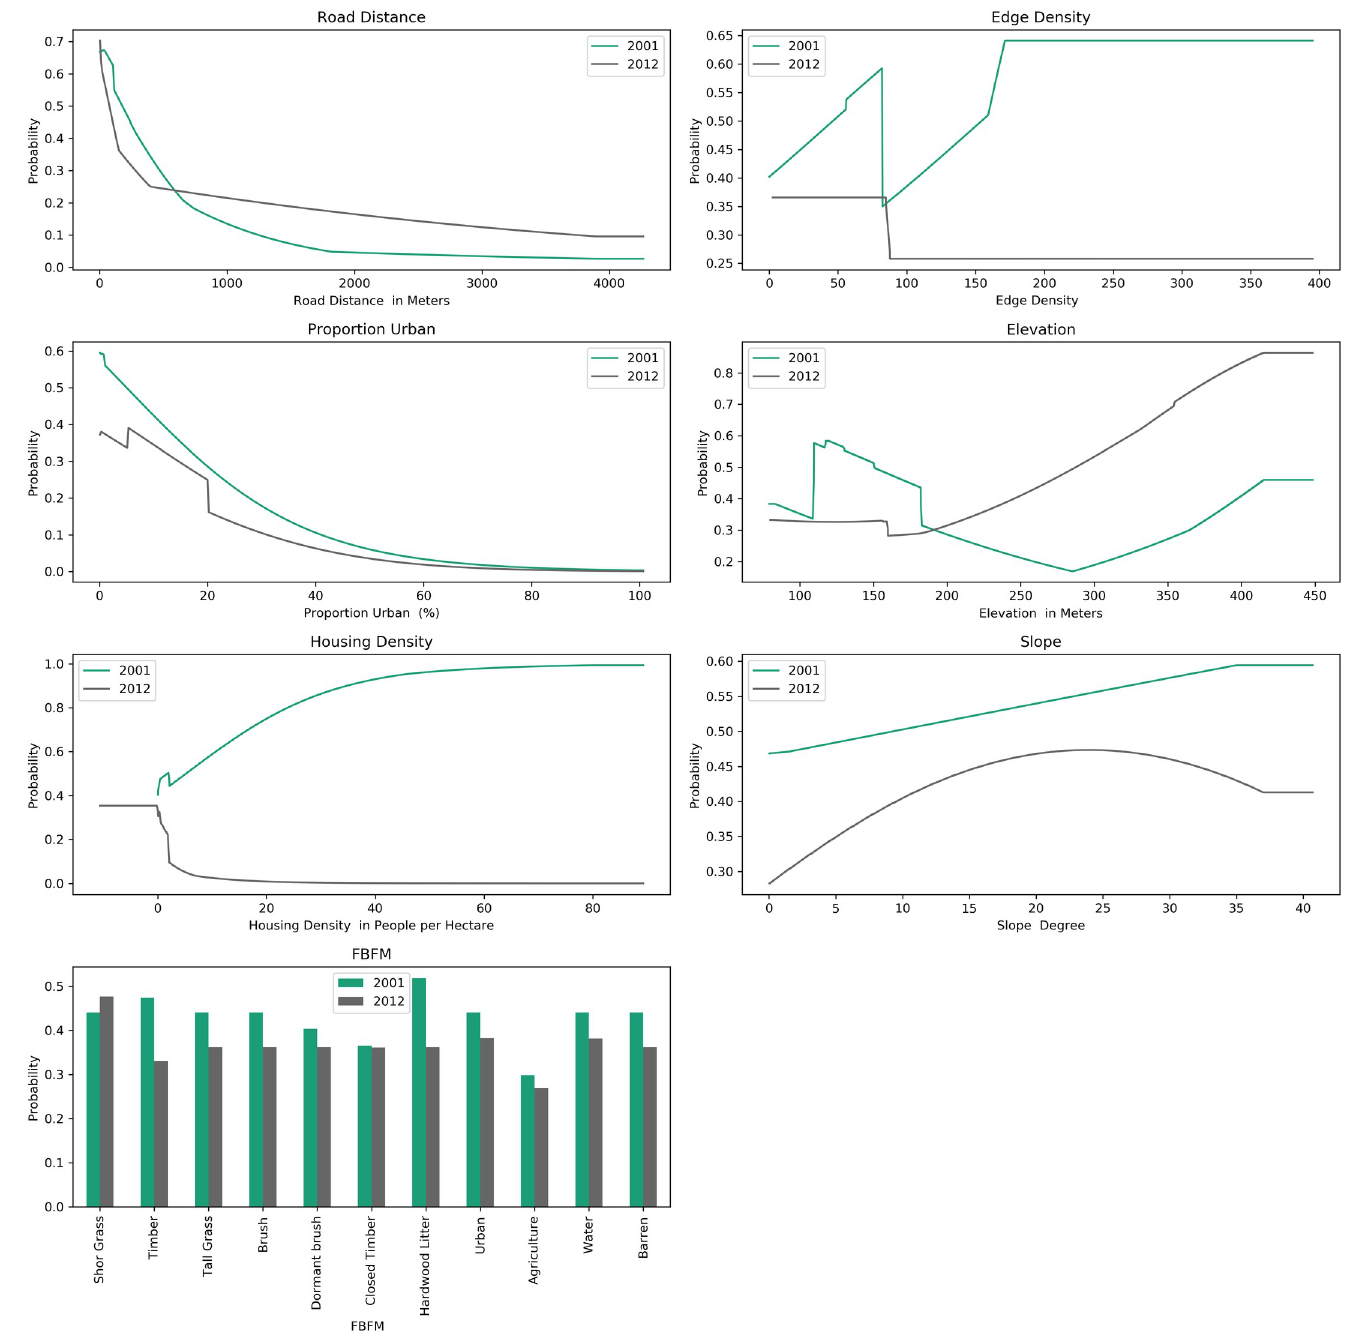
Fig 6. Variable influence on MaxEnt across years. Note the opposite effects of housing density and slope between years.